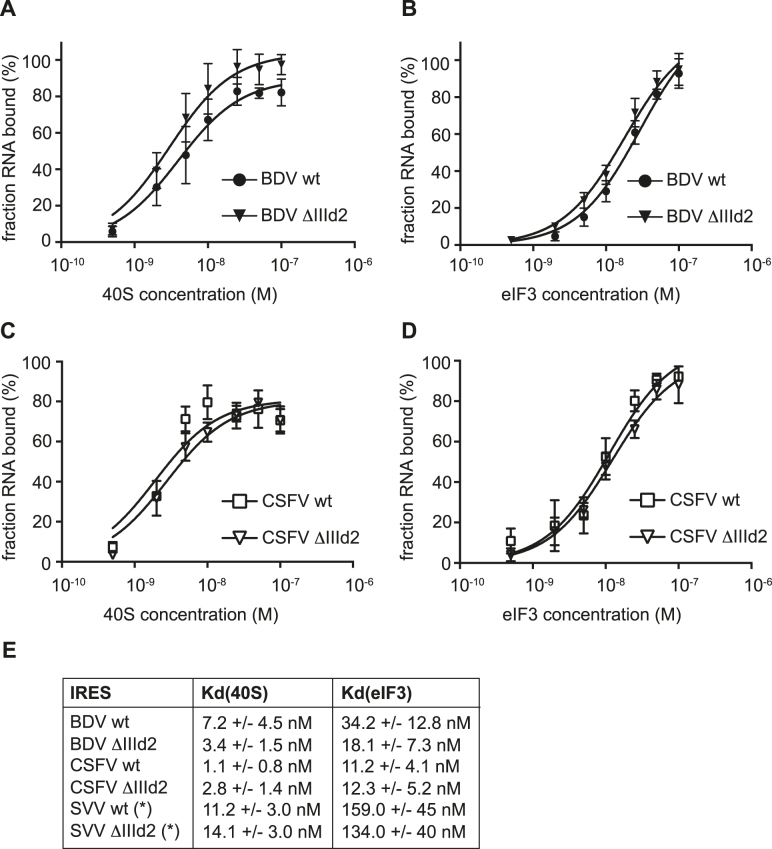
Deletion of sub-domains IIId2 does not affect the recruitment of 40S subunits and eIF3. (A and B) Binding curves of 32P-labeled wild-type (wt) or the ΔIIId2 mutant BDV IRES RNA transcripts to purified human 40S subunits or eIF3. Labeled RNAs were incubated with 40S subunits (A) or eIF3 (B) and binding assessed by filter binding assay. (C and D) Binding curves of 32P-labelled wt or ΔIIId2 CSFV IRES RNA transcripts to purified human 40S subunits or eIF3. Labelled RNAs were incubated with 40S subunits (C) or eIF3 (D) and binding assessed by filter binding assay. (E) Summary of dissociation constants (Kd) calculated for 40S and eIF3 binding to wt and ΔIIId2 mutant IRES transcripts. For comparison Kd values for the SVV IRES previously determined by Willcocks et al. 2011 are shown (28). Indicated values are the average from a minimum of three repetitions with standard errors. All calculations were performed with GraphPad Prism 7.